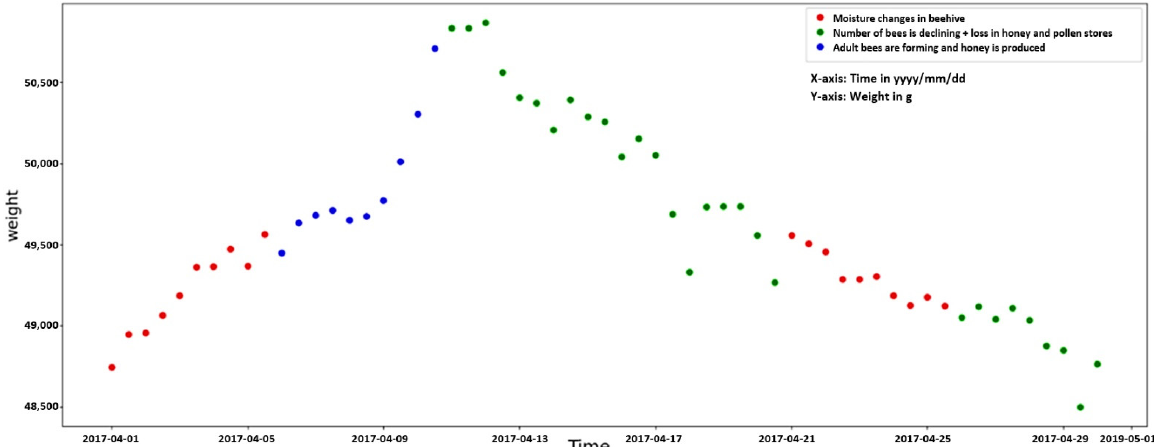
Figure 6. Weight analysis over the month of April showing dryness and food consumption, outgoing bees, and incoming bees with nectar collection during spring season.